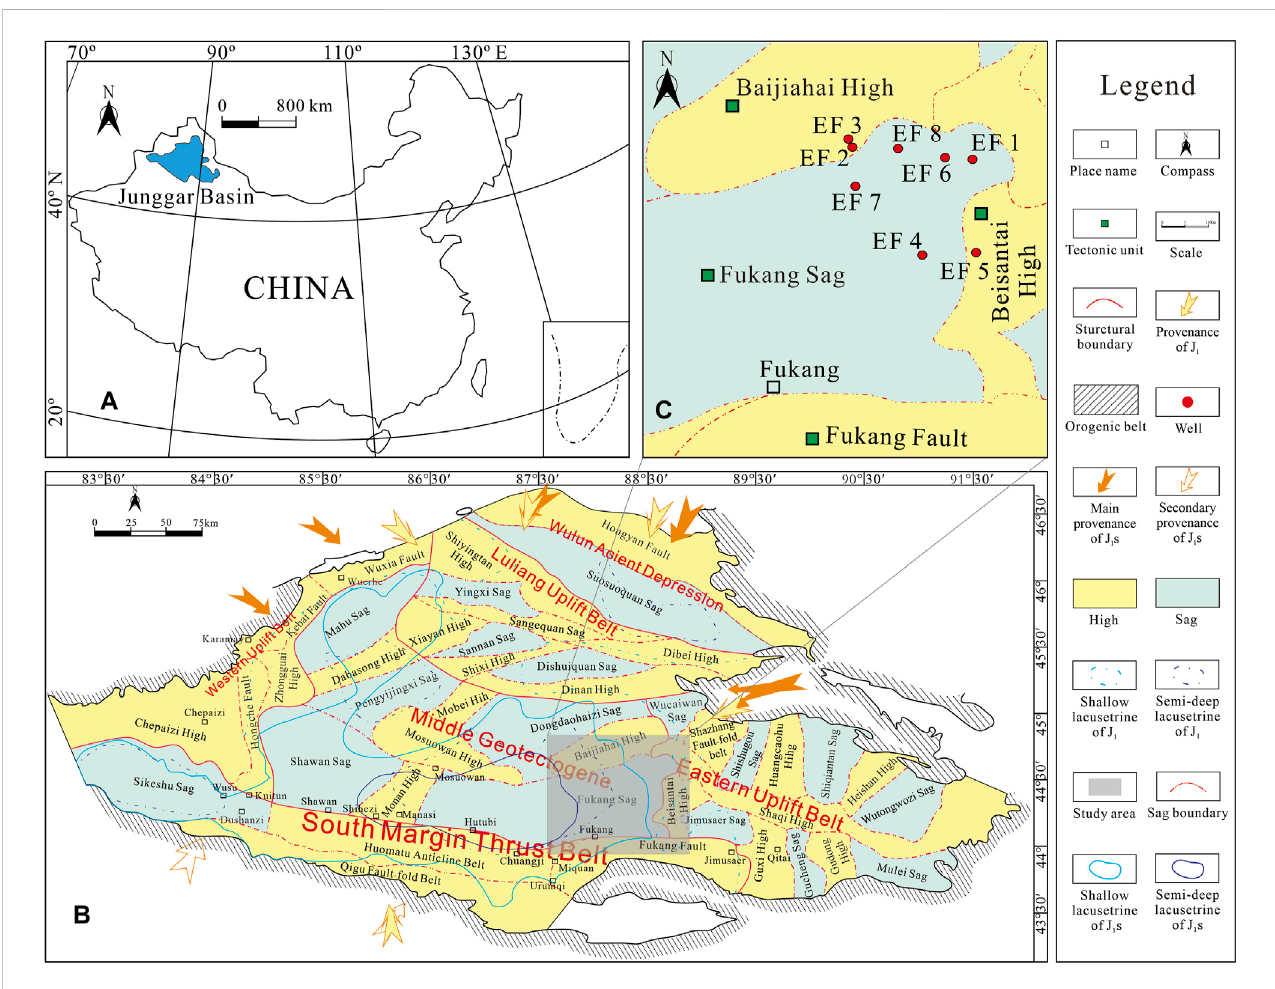
FIGURE 1 (A) The location of theJunggar Basin at present inChina, (B) its structure outlinemap (the area oflake in J 1 is after Bian et al. (2010)and in J 1 s isafter Zhu et al. (2017)) and (C) the study